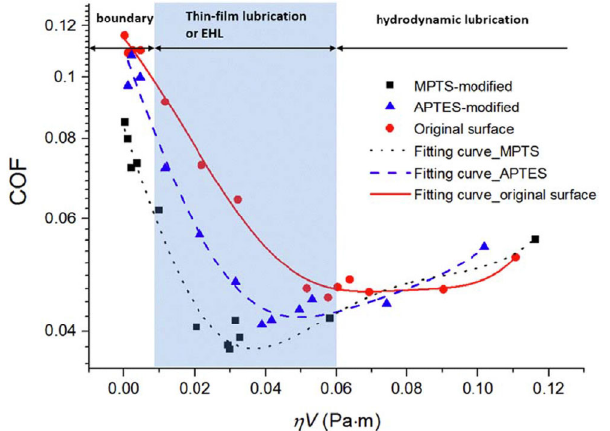
Fig. 54 Stribeck curves on different substrate surfaces [859]. Reproduced with permission from Ref. [859], © American Society of Mechnaical Engineers, 2020.